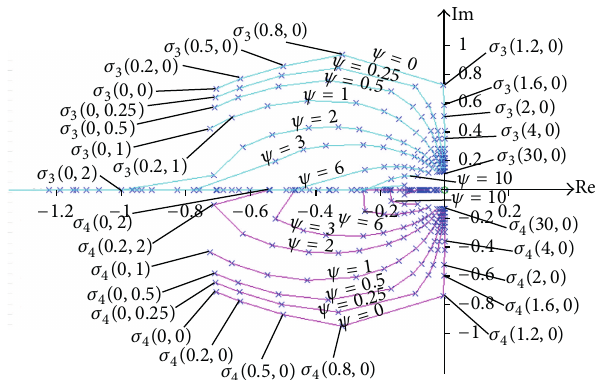
Figure 8: 𝑥 𝑎𝑑 as function of 𝑡 𝑎𝑑 , parameter sets of Table 2.